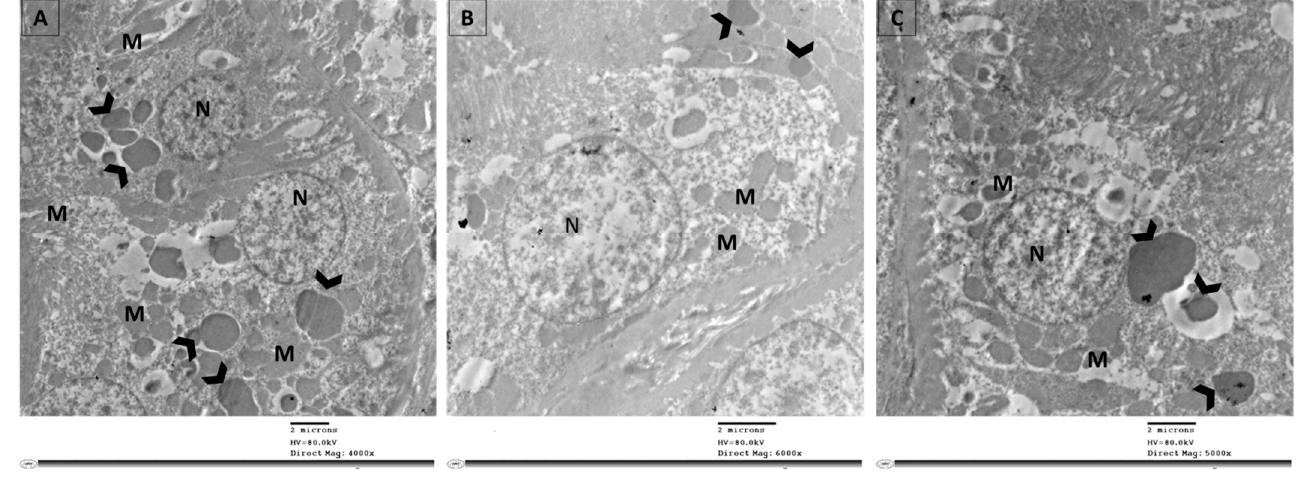
11 Figure 6. Effect of rapamycin and fasting on autophagosome formation in kidney tissue of rats after administration of STZ as viewed by TEM. ( A ) Renal proximal tubular cells of the control group showing normal nucleus (N), elongated abundant mitochondria (M) arranged perpendicular on trilamillar basal lamina (arrow), tight junctions (arrowhead). ( B ) Renal prox- imal tubular cells of STZ rats showing nucleus (N) with severe indentation of nuclear membrane, chromatin condensation, and margination suggestive of apoptotic processes. There is dilated intercellular space (arrow) showing swelling of endo- thelial cells (arrowhead). Mitochondria (M) are of different shapes and size which are also disoriented and showing swell- ing. ( C ) Renal proximal tubular cells of STZ rats that were administered rapamycin showing shrunken indentated nucleus (N), membrane blebbing, multiple apoptotic bodies (AB), and few autophagosomes (AU). There is great loss of cytoplas- mic organelles, and the few abundant mitochondria (M) are disorganized. ( D ) Renal proximal tubular cells of fasting STZ